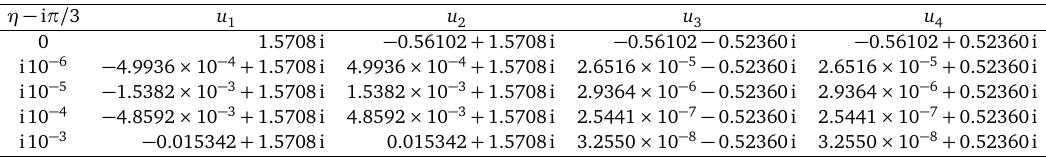
〉 as η changes away from i π/ 3. } 4 m m = 1